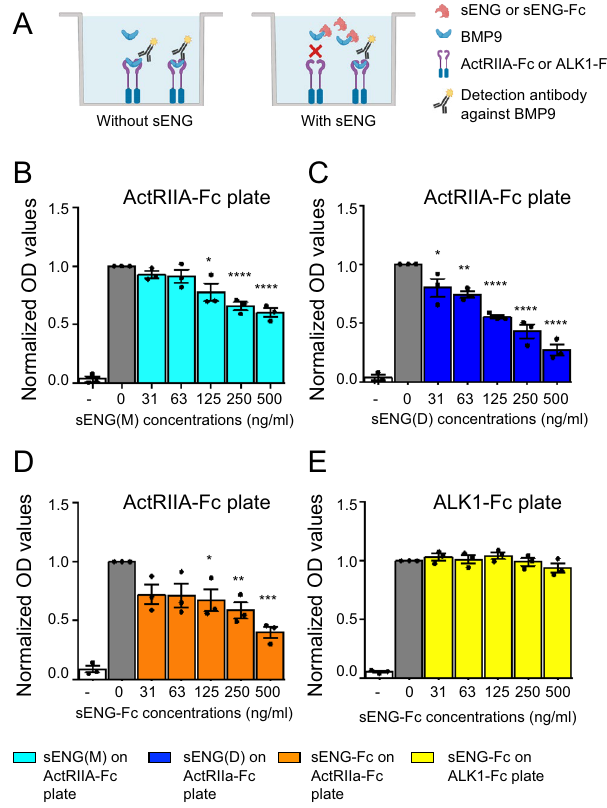
Figure 3. sENG inhibits BMP9 binding to the type II receptor ActRIIA but not the type I receptor ALK1. ( A ) Schematic showing the ELISA set-up where BMP9 is captured using Fc-fusion receptors (ActRIIA-Fc or ALK1-Fc). Binding of BMP9 is detected with a BMP9 specific, enzyme-conjugated antibody. The different added sENG variants compete with BMP9 to give a concentration-dependent reduction in the antibody signal. Created with BioRender.com. ( B-D ) ELISA plates were coated with type II receptor ActRIIA-Fc, followed by incubating with BMP9 (15 ng/mL) alongside increasing concentrations of sENG(M) ( B ), sENG(D) ( C ) or sENG-Fc ( D ). ALK1-Fc coated plate was used as a control ( E ). The graphs represent Mean ± SEM from N = 3 independent experiments. One-way ANOVA with multiple comparison of effect of sENG to no sENG control. * P < 0.05, ** P < 0.01, *** P < 0.001, **** P <